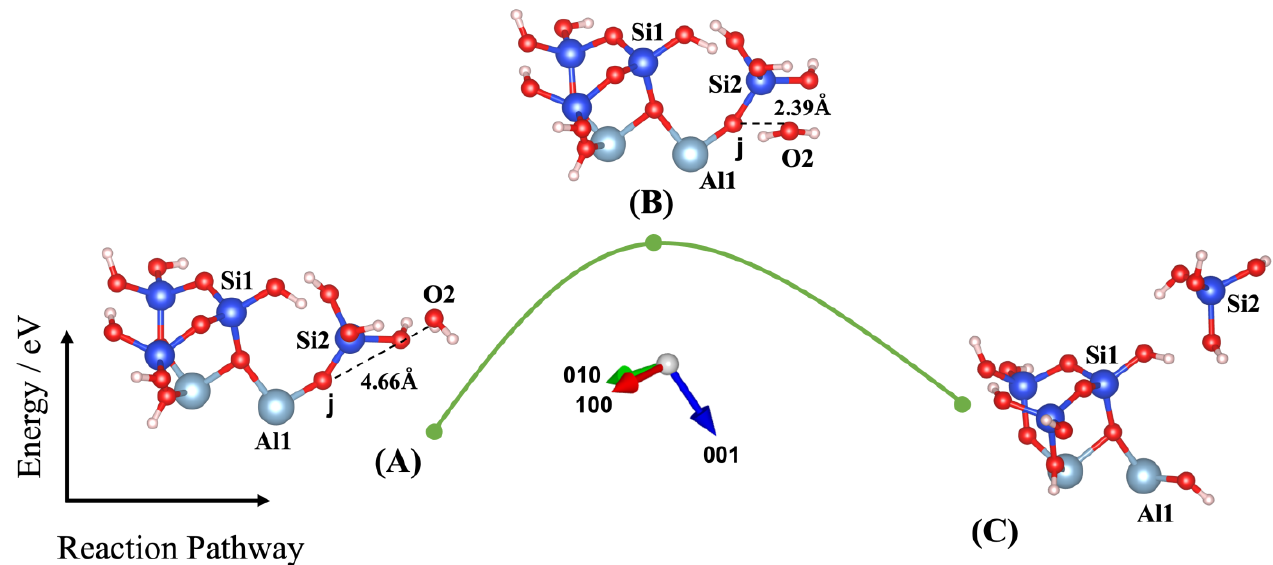
Figure 6. Model 4: ( A ) Ground state obtained as an optimized geometric structure of reactant including water molecule as absorbent on MK surface (001 ) obtained from model 1(C) for breaking the bridging oxygen, bonded to the silicate neighbor (Si1). ( B ) TS at the saddle point using improved dimer method. ( C ) Ground state obtained as an optimized geometric structure of product after protonation of the bridging oxygen, bonded to the silicate neighbor. The structure building units are described in caption of Figure 2. E _reactant, E _transition state, and E _product have been collected in Table 1.